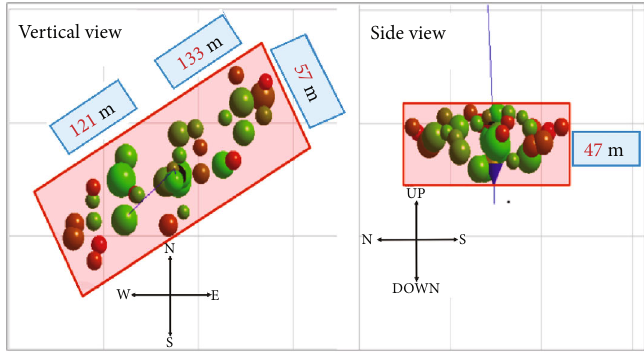
Figure 9: Test diagram of microseismic event of well Y 306-611(Chang 6